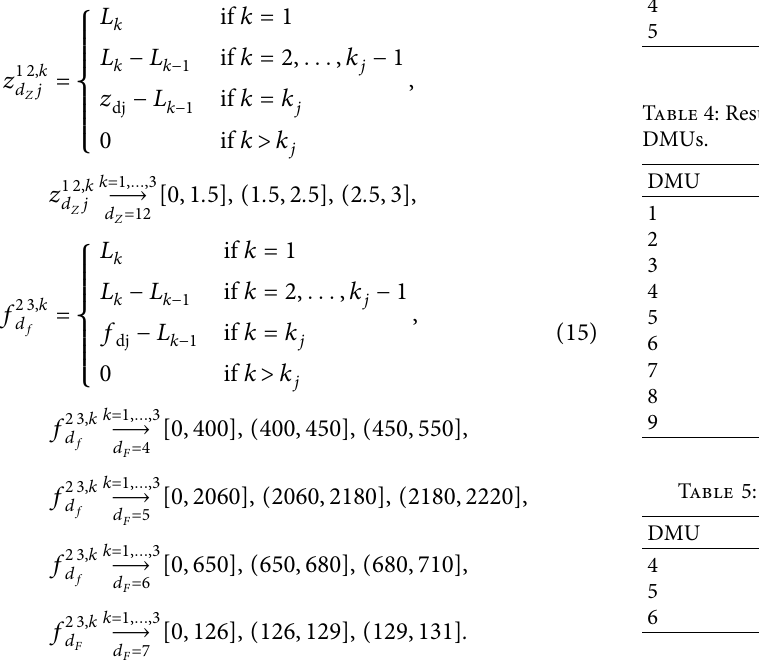
Table 6: Target values of inefficient DMUs for achieving the